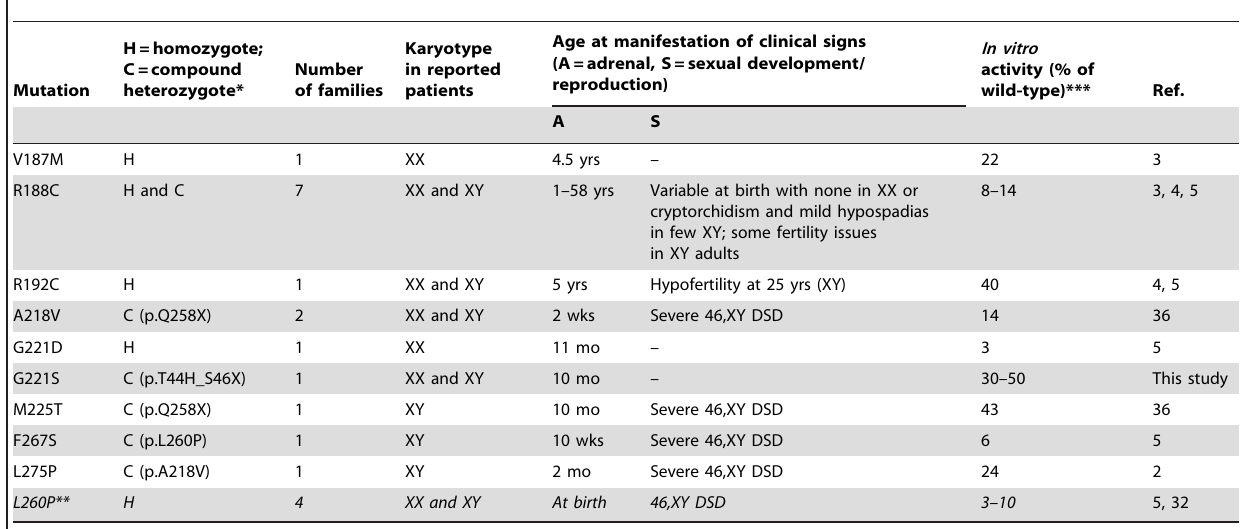
Table 1. Missense mutations identified in patients manifesting with non-classic StAR